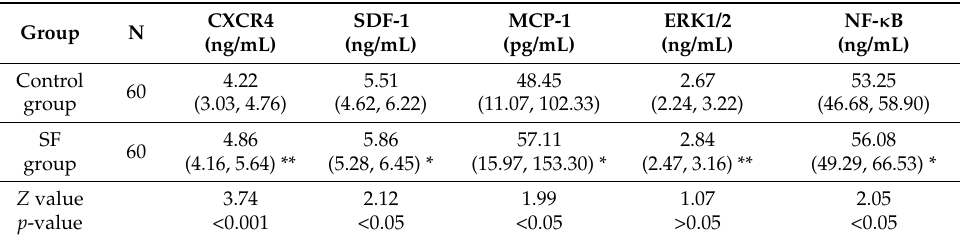
Table 3. Serum SDF-1, CXCR4, MCP-1, ERK1/2 and NF- κ B levels in the SF group and control group [M ( P 25 , P 75 )].